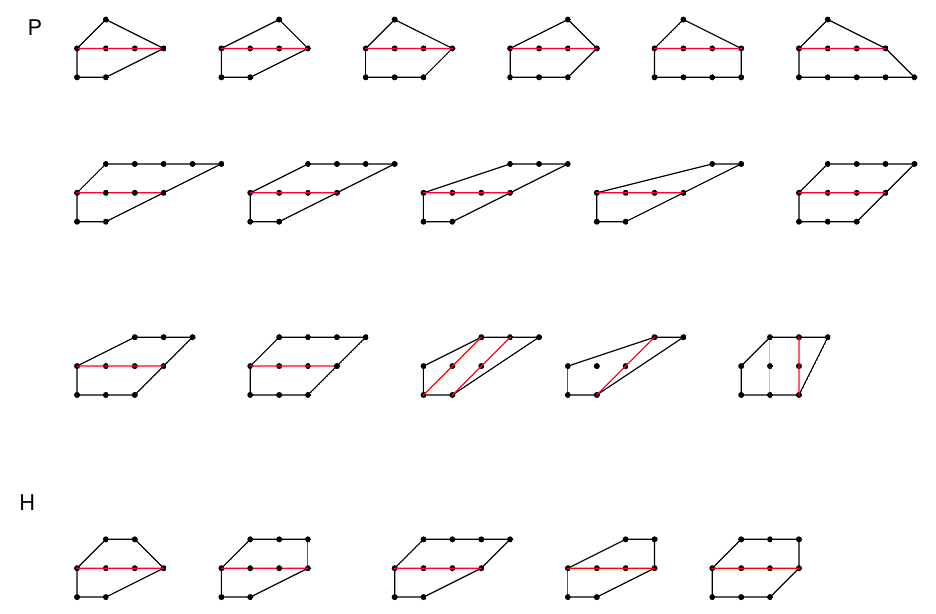
Figure 16 . Part B of toric diagram of rank two theory. The red lines indicate the partial resolution which will give a gauge theory